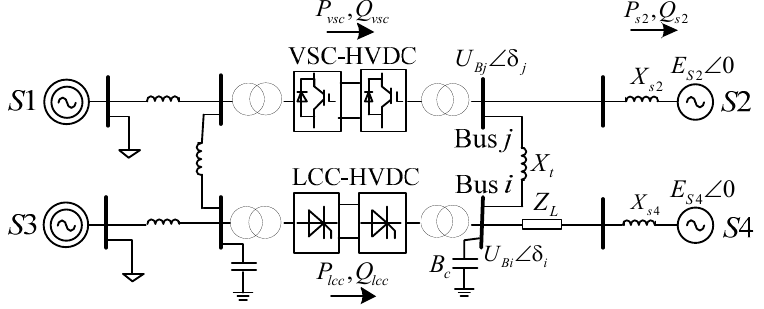
Figure 1. Diagram of the hybrid dual ‐ infeed HVDC system.